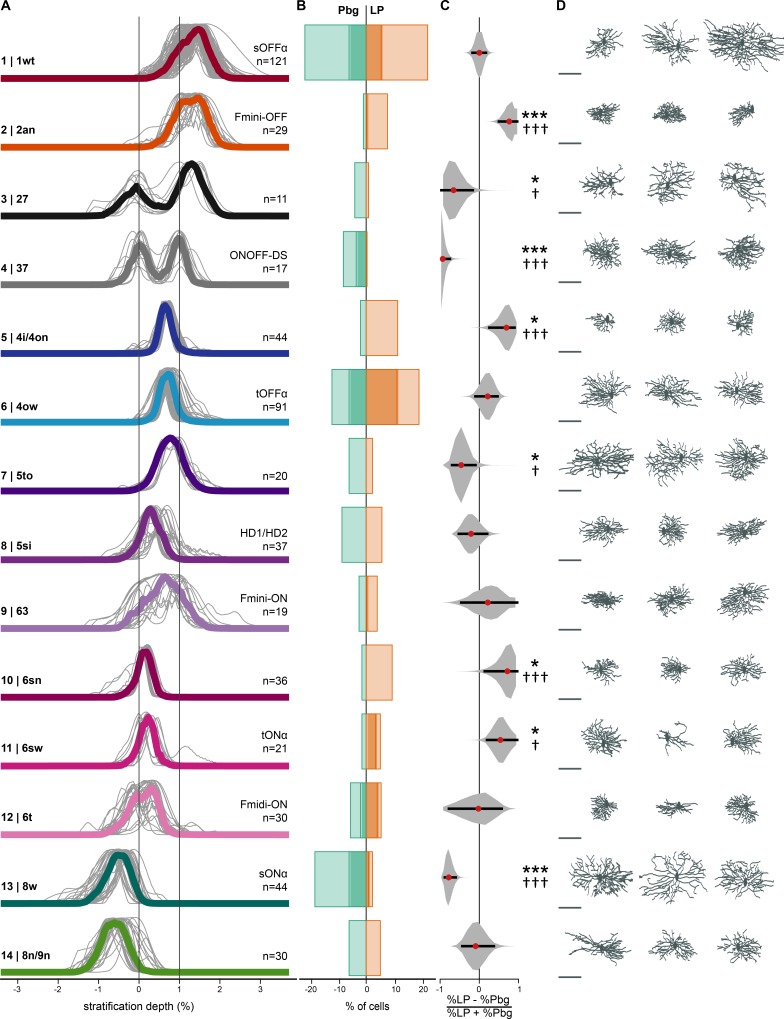
Retinal ganglion cell types targeting parabigeminal- and pulvinar-projecting collicular neurons.(A) Individual and median stratification profiles of 550 cells for the 14 cell types that innervate the colliculo-parabigeminal and colliculo-pulvinar circuit. Cluster names and additional names refer to the classification and assignment in Bae et al. (2018). (B) Percentages of cells in each cluster for both circuits (100% equals the total number of cells in a given circuit, n = 196 for Pbg and n = 354 for LP). Darker shading represents the molecularly identified neurons. (C) Biases for the two circuits expressed as percentage differences. Black lines span 2.5% to 97.5% of the data. Red dots indicate the ratio calculated from B. *p<0.05, ***p<0.001, bootstrap analysis; † p<0.05, ††† p<0.01, two proportion z-test. (D) En-face view of example cells. Scale bar: 100 µm. See also Figure 2—source data 1.Figure 2—source data 1.All 599 cells in their corresponding cluster.Positive cluster numbers are ones included in main text. Negative cluster numbers are clusters assigned less than 1% of the total population. Scale bar: 100 µm.